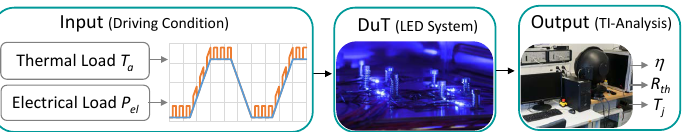
Figure 11. Reliability workflow of the dataset [52] using thermo–electrical loading conditions as input parameters to age the LED system. Thermal impedance (TI) analysis is further used for intake and a sequential analytical method to evaluate the status of the device under test